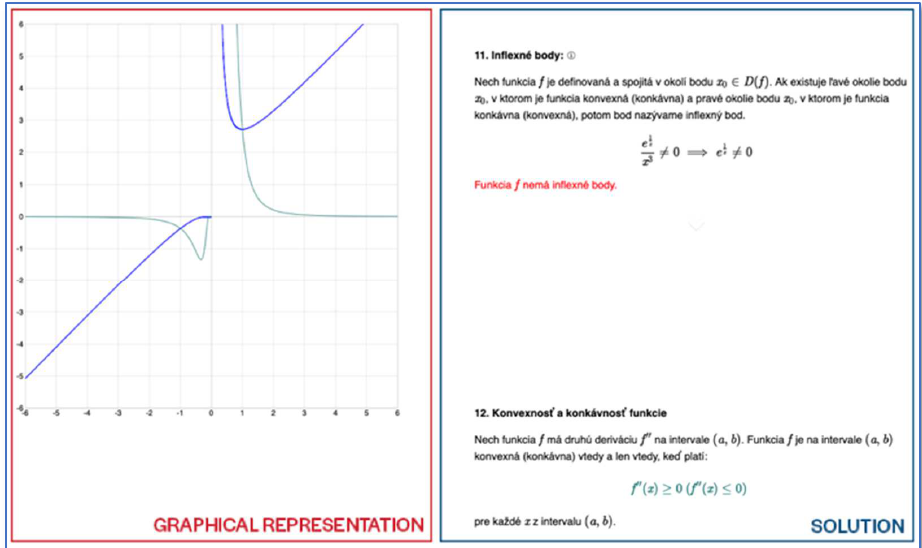
Figure 5. An example of an interactive JavaScript web page step–by–step explanations to a sample solution. Color frames denoting separate areas are added for clarity.